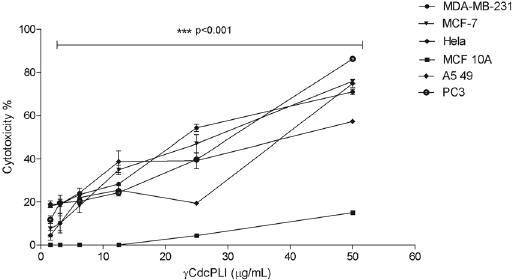
Figure 1. Cytotoxicity induced by γ CdcPLI in breast cells by MTT cytotoxicity assay. Breast cancer cells (MDA-MB-231 and MCF-7), Lung cancer cell (A549), Prostate cancer cell (PC3), Cervix cancer cell (HeLa) and the non-tumorigenic breast cells (MCF 10A) were treated with γ CdcPLI (50, 25, 12.5, 6.25, 3.125 or 1.56 µ g/ mL) for 24 h. All data are expressed as mean ± S.E.M and procedures were carried out in triplicate; statistically significant, *** p < 0.001, treatments compared to control (MCF 10A).